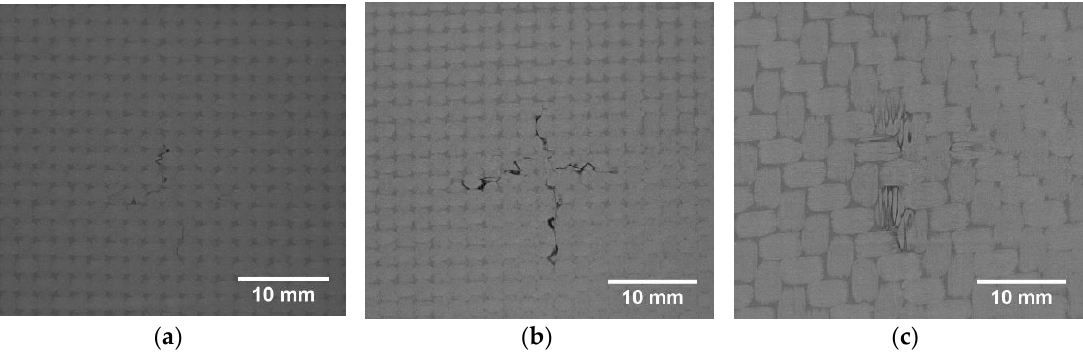
Figure 15. Representative X-ray CT scans with visible damage (from 250 slices): ( a ) no. 18; ( b ) no. 20; ( c ) no. 99.